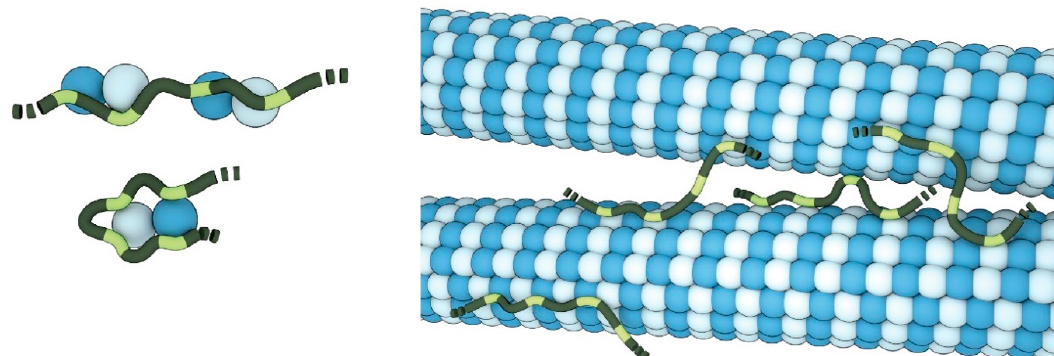
Figure 2. Disordered microtubule-binding proteins. The dynamic nature of the CC1- and Tau-binding (dark- and light-green) behaviour suggests that both might be able to bind multiple distinct tubulin dimers (light- and dark-blue) via their individual binding motifs (light-green), thereby increasing the local tubulin concentration, connecting and stabilizing protofilaments or bundling microtubules. Image by Barth van